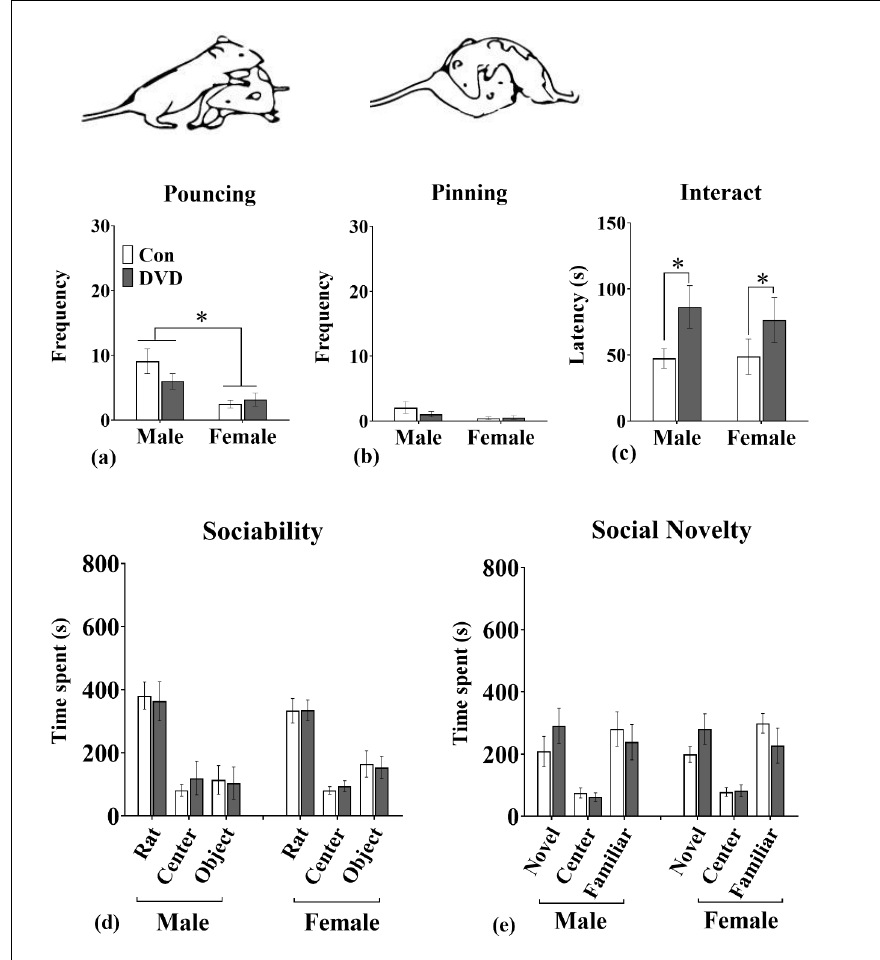
Figure 5. Social play and three chamber social interaction assay (Cohort 3). DVD-deficiency did not affect frequency of (a) pouncing and (b) pinning. However, DVD-deficiency significantly enhanced (c) latency to start interaction in both male and female rats. Male pairs n = 24, control male pairs n = 24, DVD female pairs n = 24 and control female pairs n = 22. In the three-chambered assay, (d)